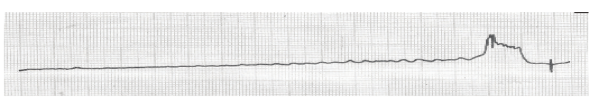
FIGURE 3 - Bladder pressure measured with the cystostomy catheter (VP2).